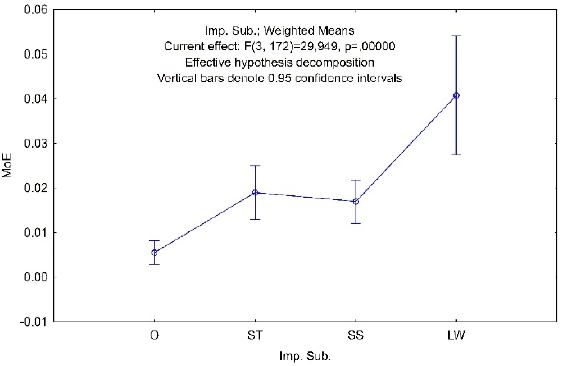
Figure 17. Tukey HSD test result for factor Imp. Sub.